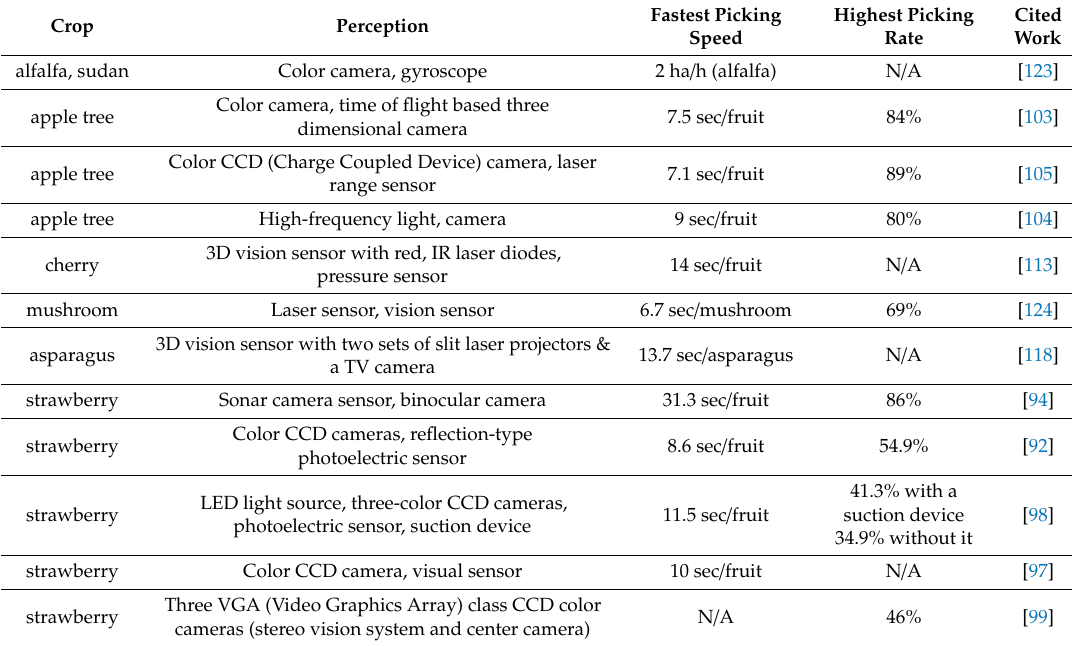
Table 7. Harvesting agrirobotic systems’ features for various